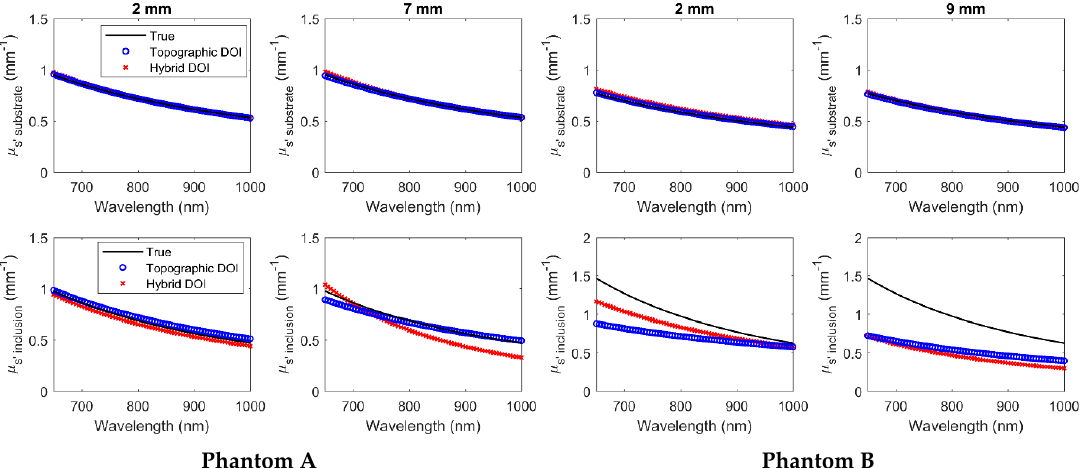
Figure 12. Hyperspectral substrate (row 1) and inclusion µ s (cid:48) (row 2) at wavelengths 650 nm to 1000 nm for phantoms A and B.